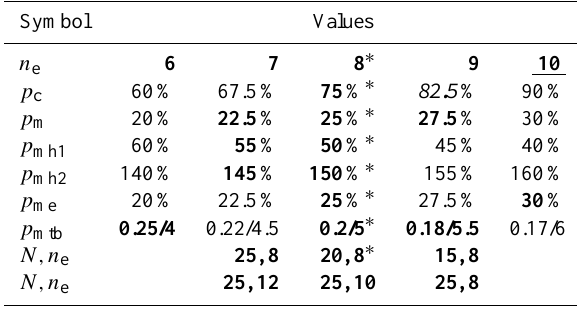
Table 8. Uncino landslide case study. Values of the parameters adopted in the sensitivity analyses. In bold, the experiments with (cid:56) max = 1. In italics, the worst experiment. Underlined, the best one.